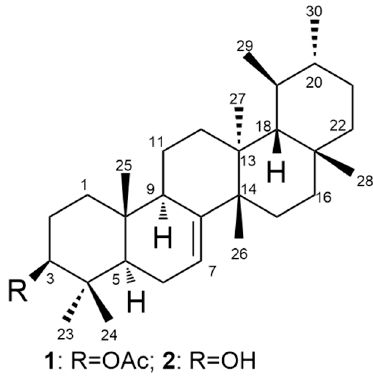
Figure 1. Structure of compounds 1 and 2 .